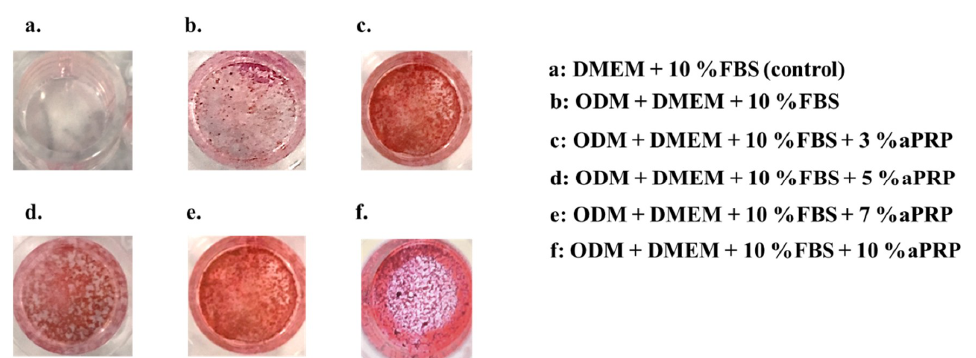
Figure 9. Twenty‐one days after Alizarin red staining: ( a ) Dulbecco’s modified Eagle’s medium Figure 9. Twenty-one days after Alizarin red staining: ( a ) Dulbecco’s modified Eagle’s